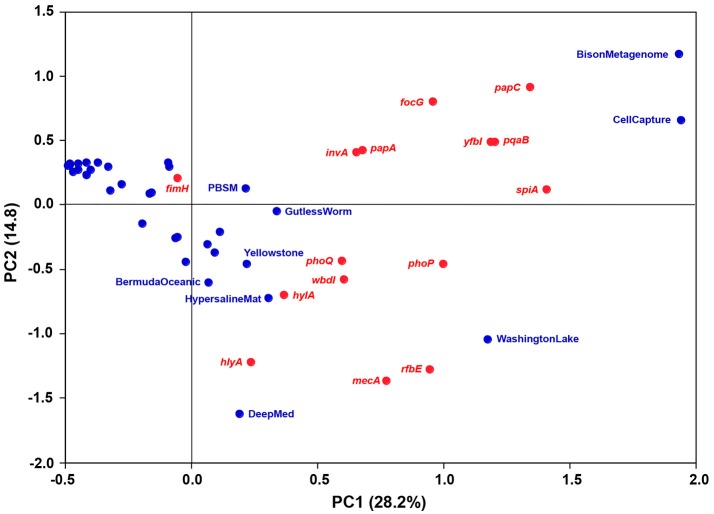
Bi-plot of principal component 1 (PC1; 26.4% explained variance) and 2 (PC2; 14.2% explained variance) of the PCA model. Metagenomes are marked in blue, while virulence gene homologs are marked in red.